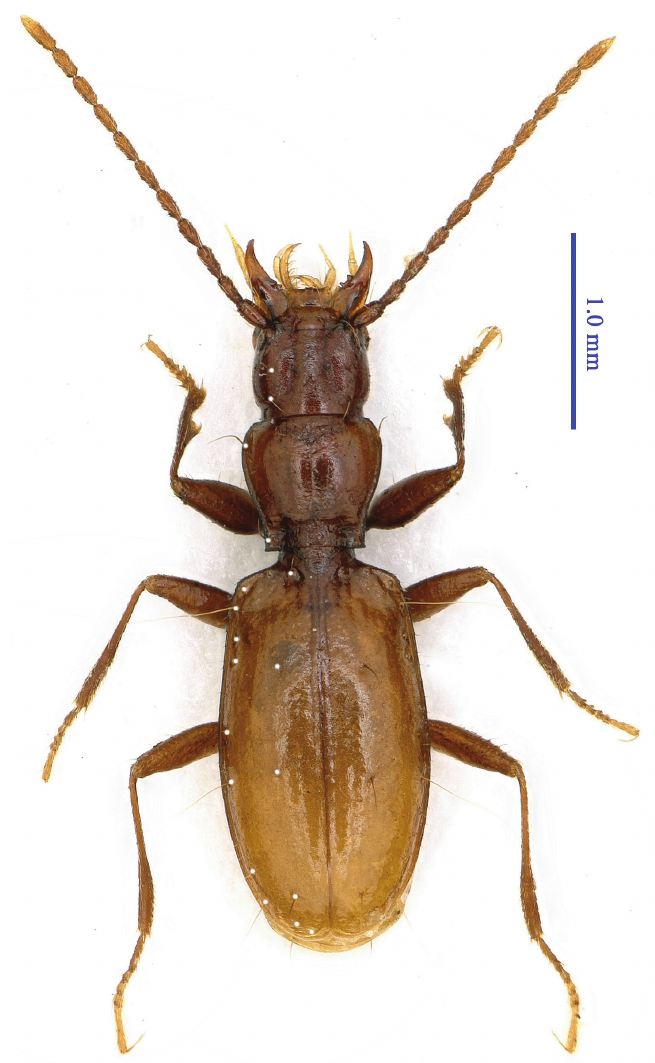
Figure 4. Habitus of Wanoblemus wui Tian & Fang, gen. n., sp. n., male, holotype. Head subquadrate, longer than wide, HLm/HW = 1.5, HLl/HW = 1.4; front and vertex moderately convex; frontal furrows fairly long and complete, nearly paral- lel medially; genae slightly expanded laterally; anterior supraorbital pores located in the middle of genae, sub-equidistant to lateral margin of genae and to posterior pore; clypeus 4-setose, labrum transverse, nearly straight in the front margin, 6-setose; man- dibles distinctly curved at apex; ligula short, adnated with paraglossae, 6-setose at apex; palps short, penultimate joints much stouter than apical joints; labial palpomere 2